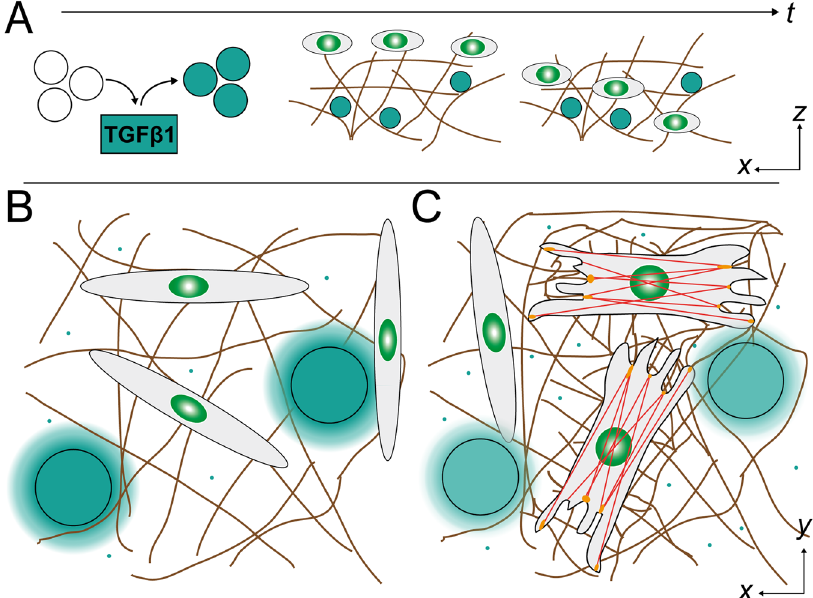
Figure 1. Scheme of experimental setup. ( A ) Time course of cell experiments. Prior to experiments GAG- functionalized µ -beads were laden in TGF β 1 (cyan) solutions with defined loading concentrations. TGF β 1- laden µ -beads were already present during collagen network (brown) reconstitution and immobilized in the fibrillary network. After overnight equilibration of the network with cell culture medium, fibroblasts were seeded on top of the collagen networks. This is the start of cell experiments. ( B ) In the beginning fibroblasts are more elongated and apparently have no α SMA incorporated into their cytoskeleton. The cells are embedded in a 3D collagen network (brown). ( C ) After stimulation by TGF β 1 (cyan small dots) delivered from µ -beads (cyan large dots) fibroblasts transform into tissue-producing and -contracting myofibroblasts increasing network’s stiffness. They have a prominent cytoskeleton with incorporated α SMA (red) to connect focal adhesions (orange), which transfer the forces to the extracellular